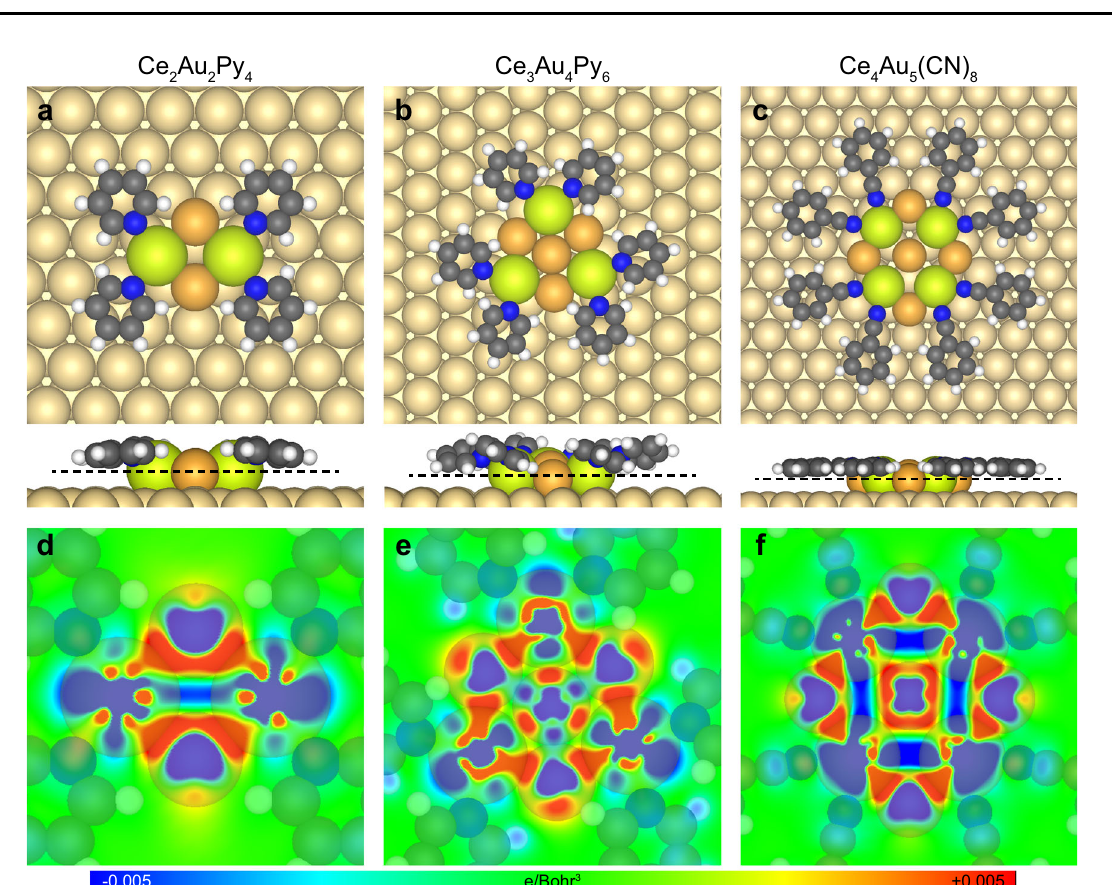
Fig. 6 Theoretical results of the multinuclear coordination structures. Optimized models of a the Ce 2 Au 2 Py 4 , b the Ce 3 Au 4 Py 6 , and c the Ce 4 Au 5 (CN) 8 motifs (upper: top view, lower: side view). Cross-sections of the differential electron densities of d the Ce 2 Au 2 Py 4 , e the Ce 3 Au 4 Py 6 , and f the Ce 4 Au 5 (CN) 8 motifs along the black dashed lines in a , b and c, respectively.